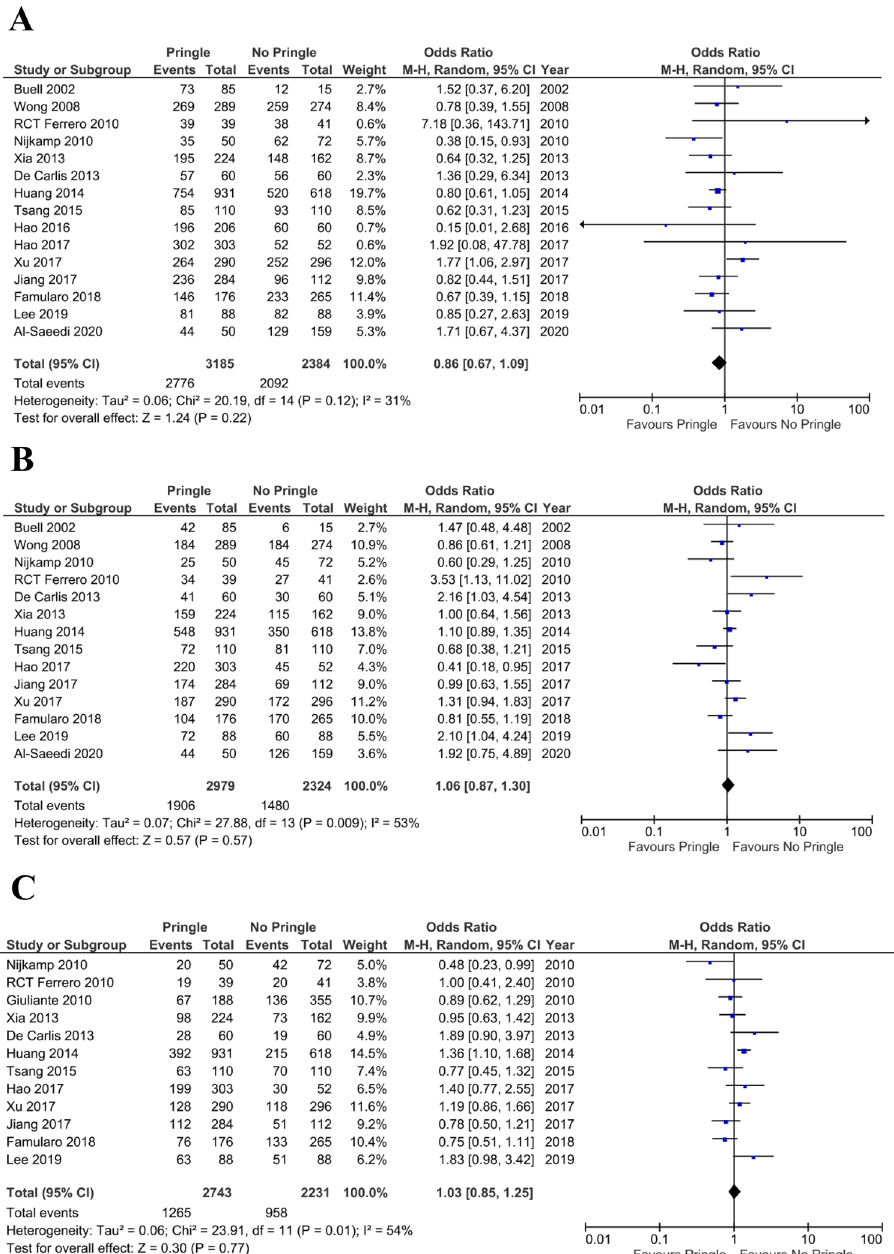
Figure 4. ( A ) Forest plot showing 1-year survival of patients with hepatic malignant lesions. ( B ) Forest plot showing 3-year survival of patients with hepatic malignant lesions. ( C ) Forest plot showing 5-year survival of patients with hepatic malignant